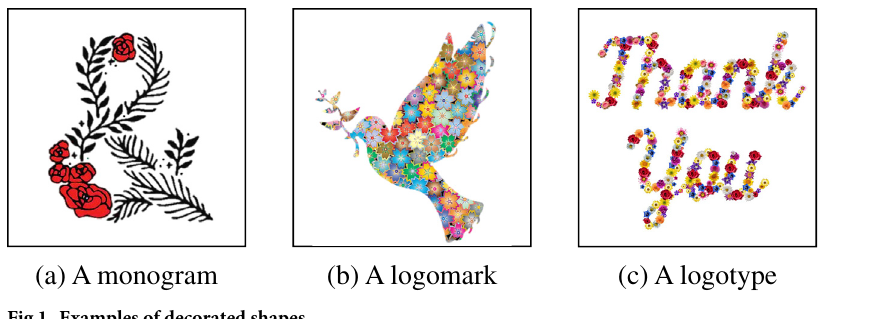
Fig 1. Examples of decorated shapes.